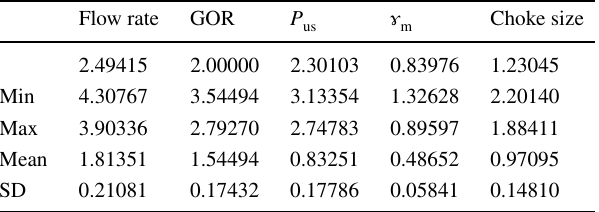
Table 5 Statistical analysis of the log data (except mixture